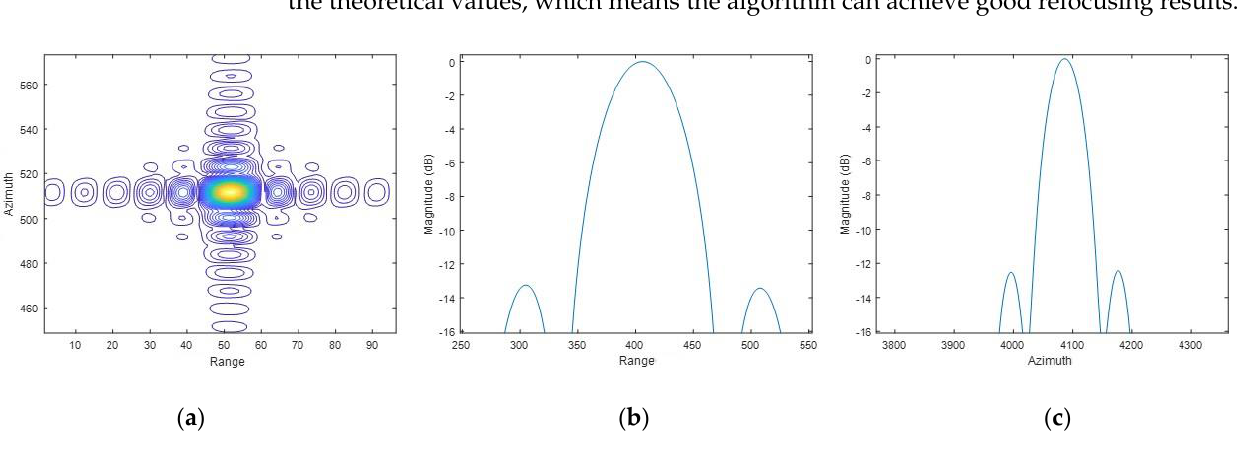
Figure 8. Refocused result of the moving target T3. ( a ) Impulse responses of T3. ( b ) Range profile of T3. ( c ) Azimuth profile of T3.